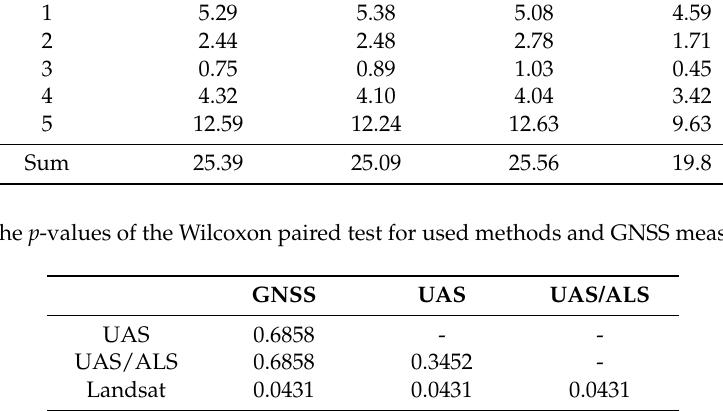
Table 1. Summary of the windthrow areas identified by all methods and reference data used from global navigation satellite system (GNSS) measurements. UAS, unmanned aircraft systems; ALS, airborne laser scanning.